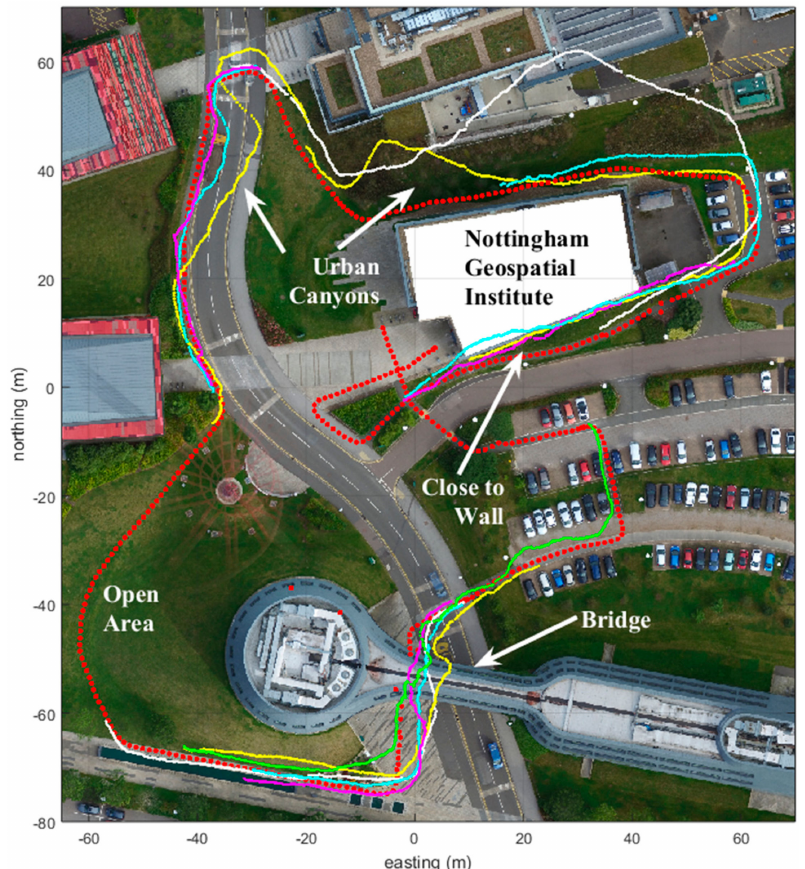
Figure 1. The red track shows the ground truth recorded using the Leica RTK kit. Other colors depict the characteristics of the anomalies in the GPS position estimations using u-Blox6 in the Microstrain 3DM-GX4-45 sensor. Measurements were taken on 23rd of September, 2016 between 11:00 and